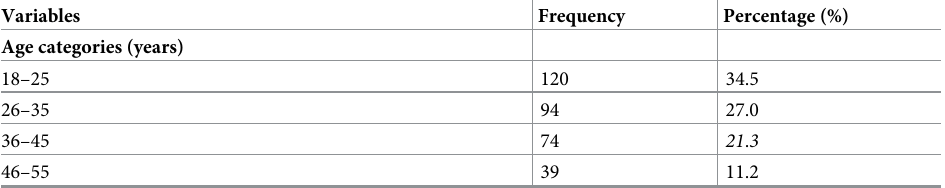
Table 1. Socio-demographic characteristics and other background information of the